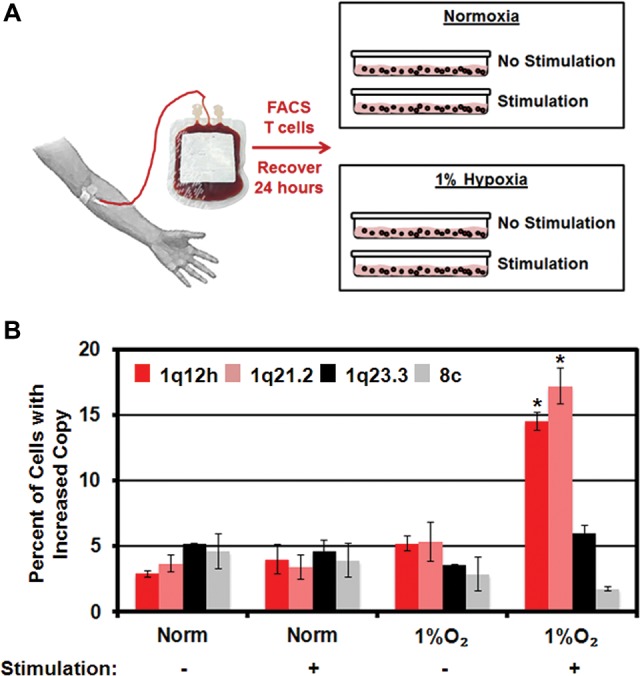
Hypoxia induces site-specific copy in primary human T cells. (A) Schematic illustrating collection, isolation, and stimulation of primary human T cells. (B) Hypoxia induces site-specific copy gain only in stimulated primary human T cells. Error bars represent the SEM. (*) Significant difference from normoxia by two-tailed Student's t-test. P < 0.05.